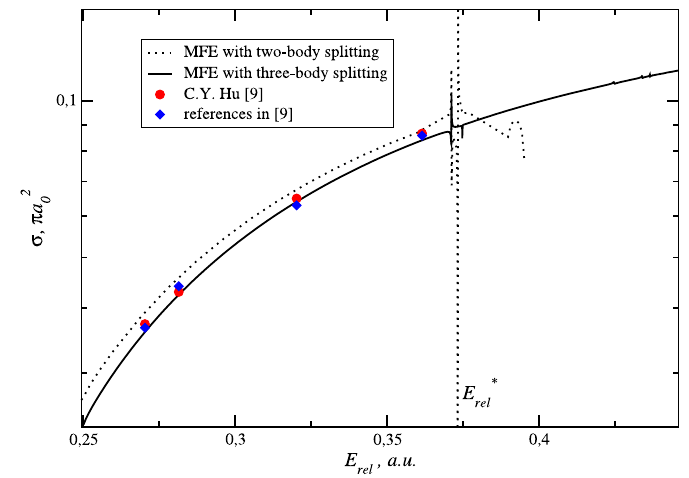
Figure 3. e + − H elastic scattering cross section calculated with different types of splitting. E rel is the energy of the system measured relative to the ground state of Hydrogen.